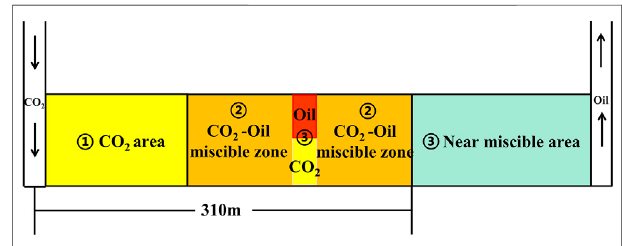
FIGURE 15 | Phase distribution between injection and production wells in steady fl ow phase.